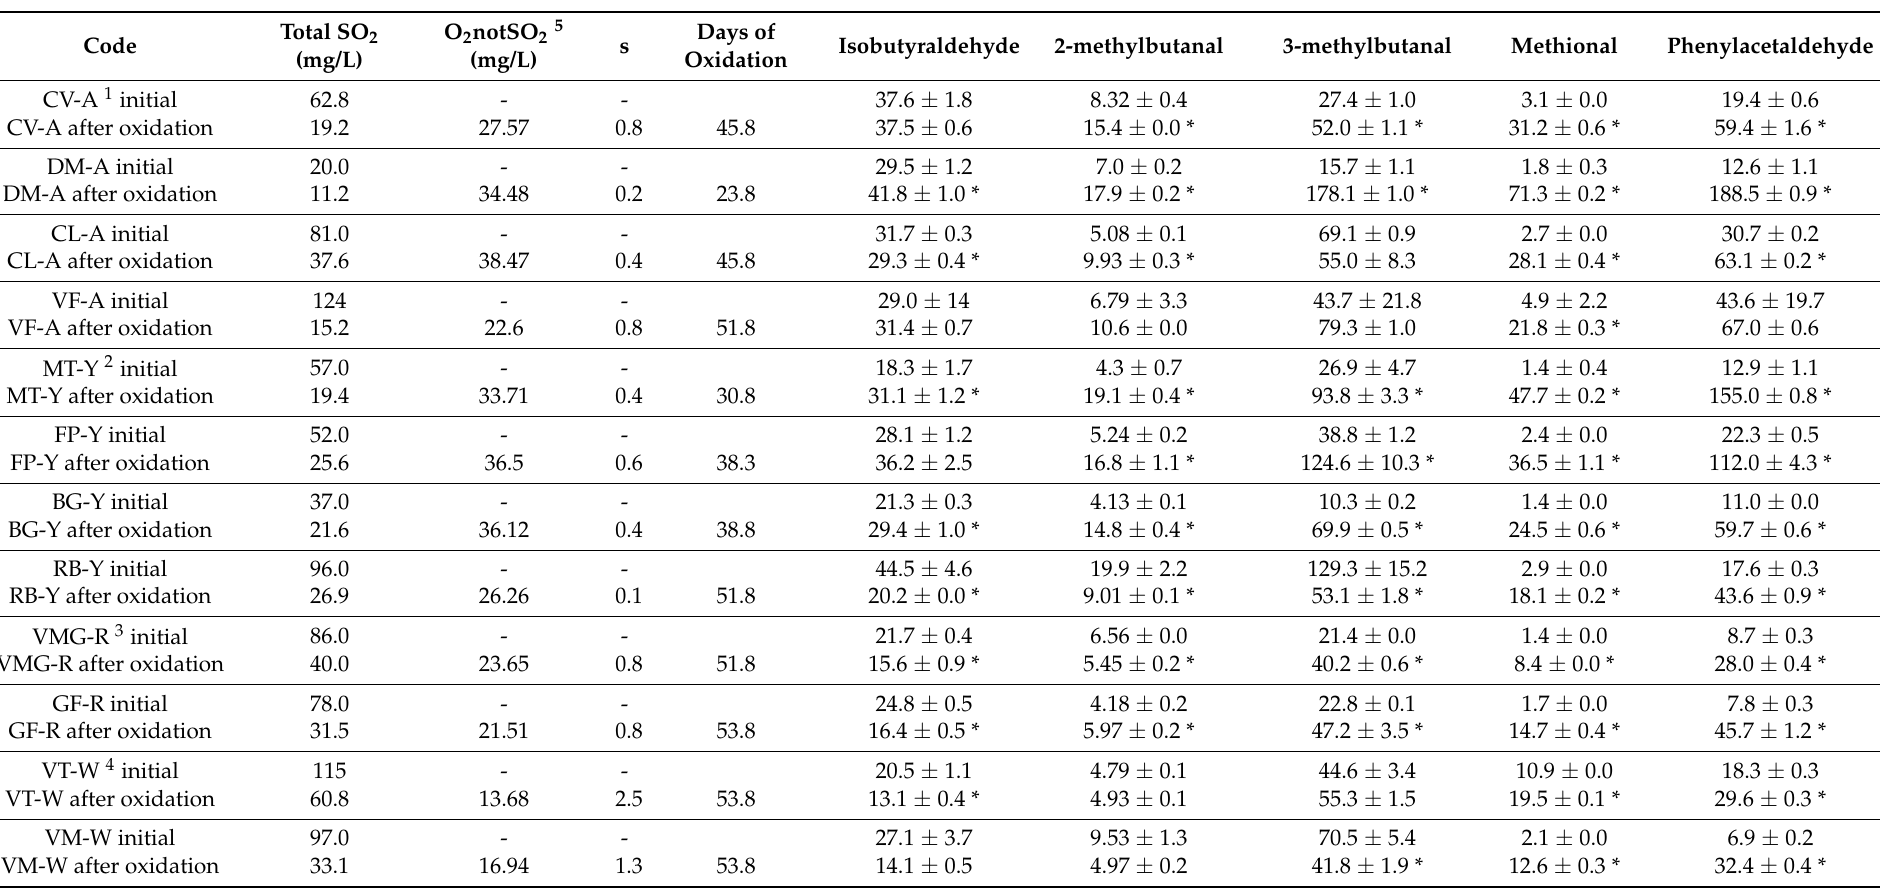
Table 2. Parameters related with the oxidation experiment and levels of total Strecker aldehydes ( µ g/L) initial and after oxidation process. s: standard deviation ( n =